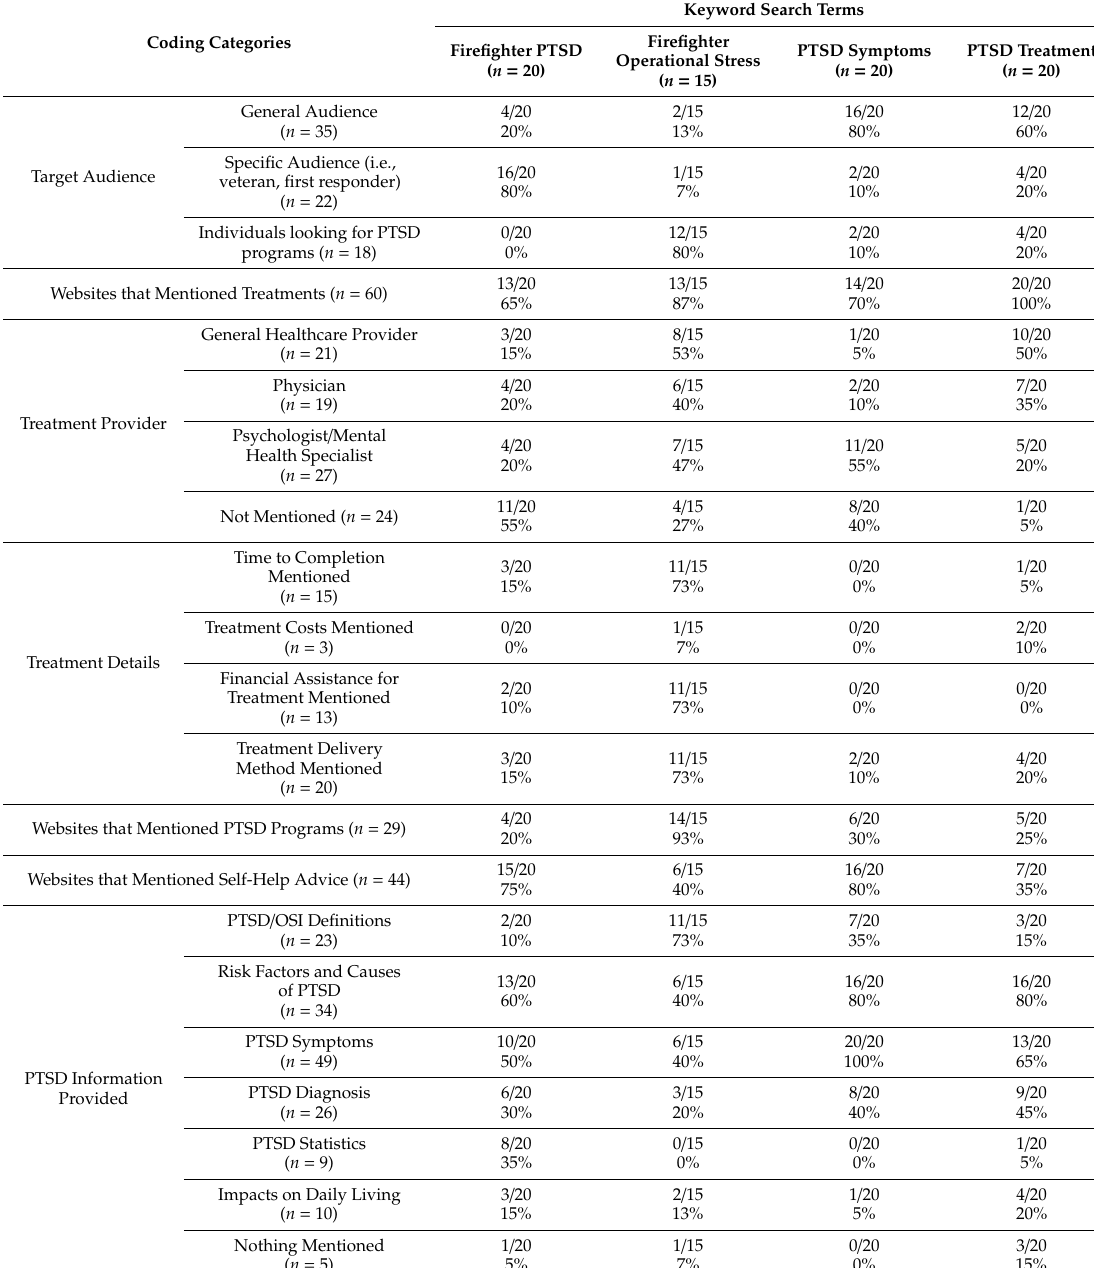
Table 2. The frequency of websites that mention the codes from the content analysis based on the di ff erent search terms. The number of websites that have mentioned the content is provided as a fraction of the total number of websites generated from the search term and the corresponding